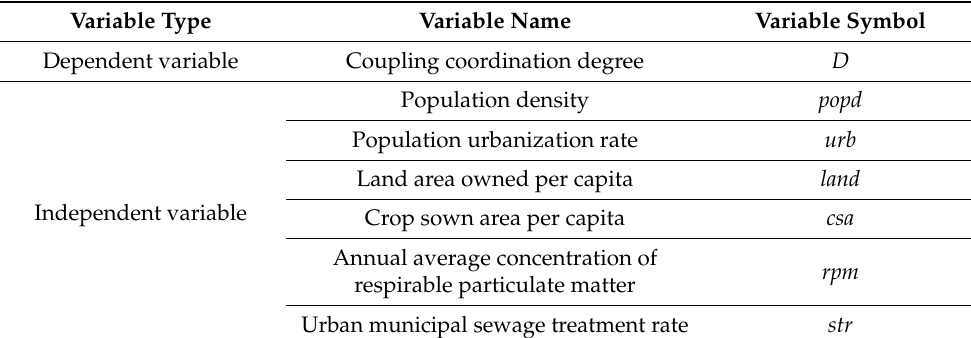
Table 2. Driving factors of coupling coordination